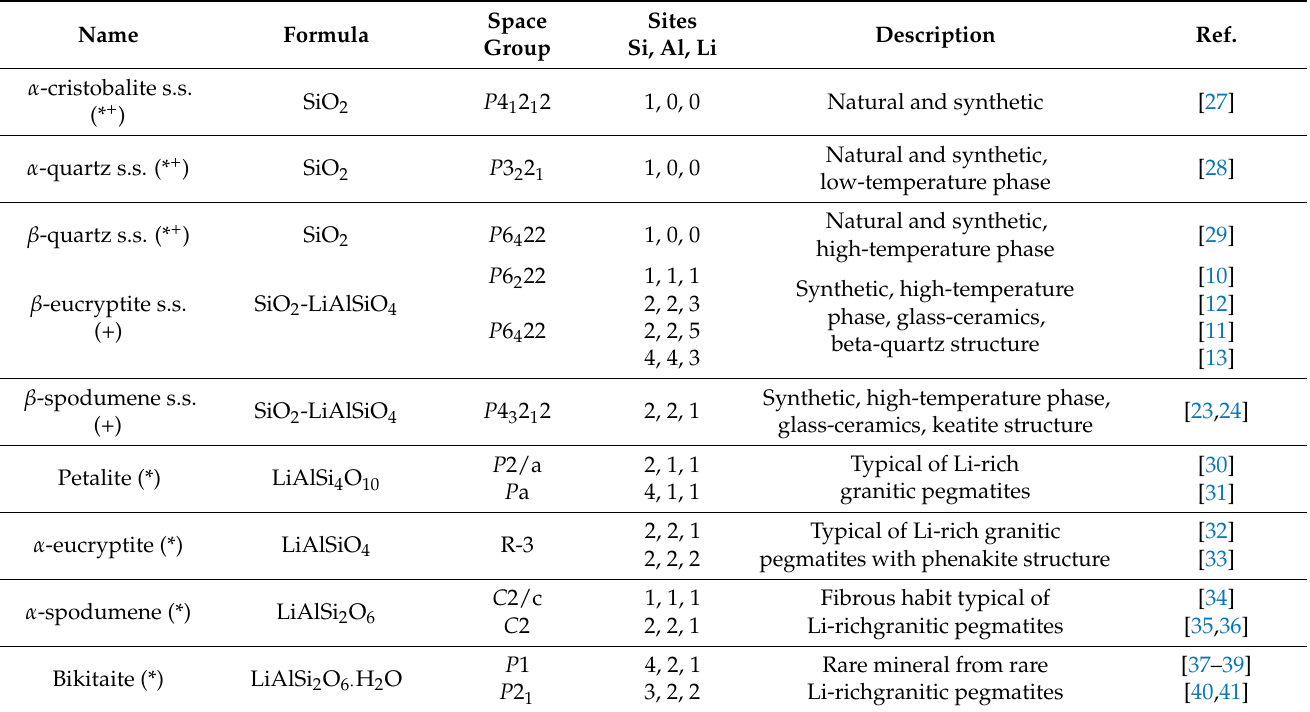
Table 1. Lattice models of the minerals (*) and ceramic phases (+) of the LAS system at room temperature and